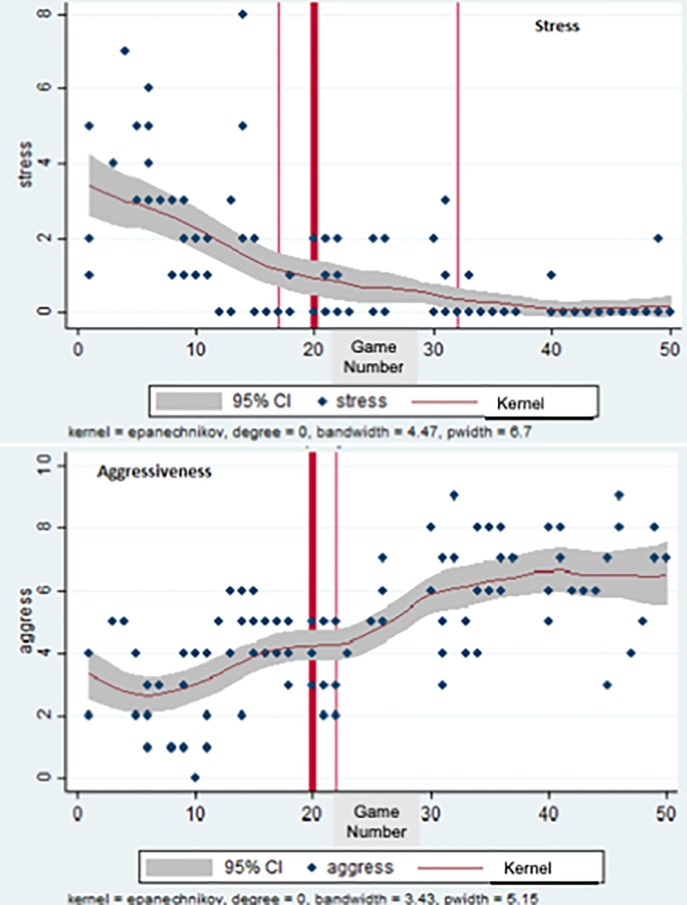
Evolution of team affective tone variables: ‘Stress’ and aggressiveness.Notes: Kernel (regression line) is a weighted local polynomial smooth regression. CI = confidence interval. The thick vertical line indicates the date of the OC leaving. The thin lines indicate structural breaks.